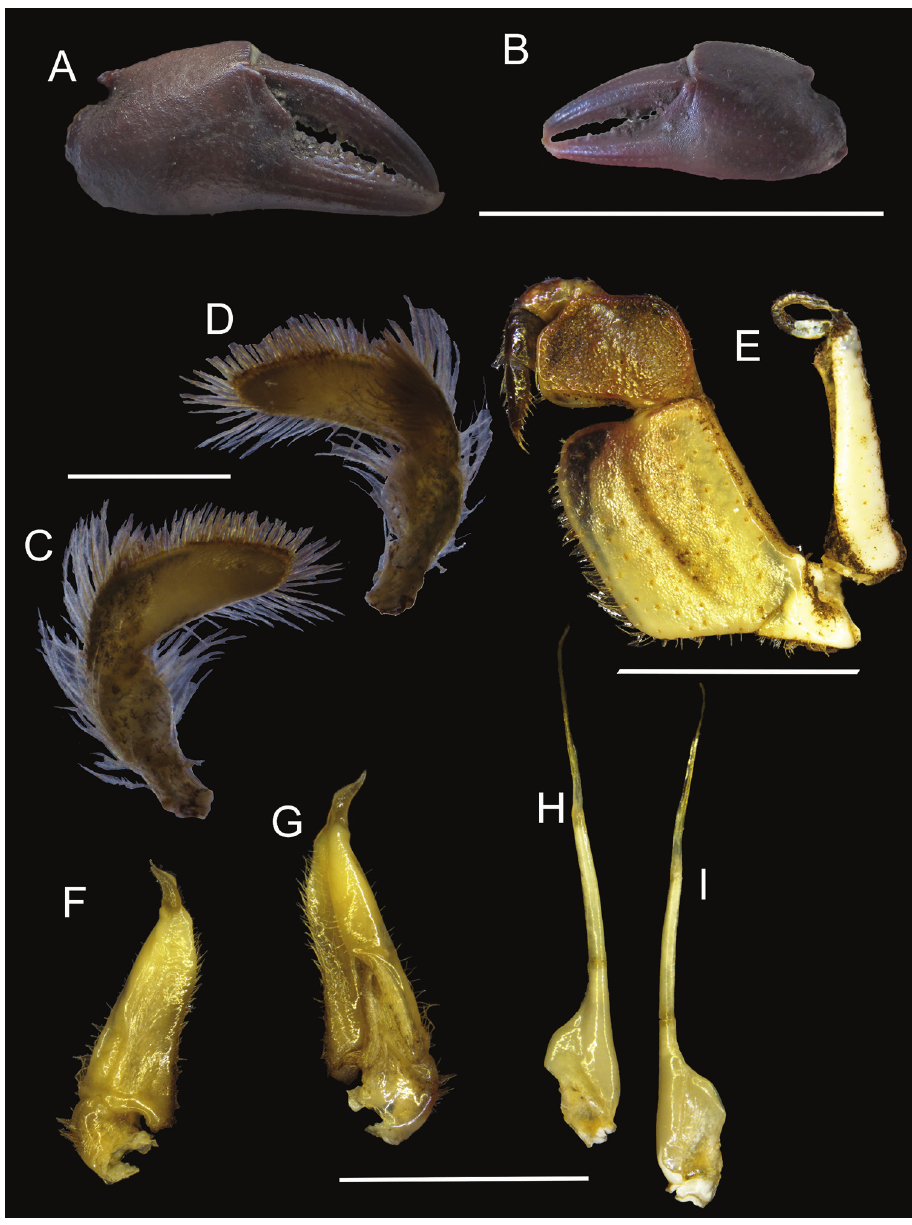
Figure 8. Potamonautes danielsi sp. n. male holotype CWW 25.8 mm (SAMC A83487). A major cheliped B minor cheliped C right mandibular palp posterior view D right mandibular palp anterior view E 3 rd maxilli- ped F left gonopod 1 anterior view G left gonopod 1 posterior view H left gonopod 2 anterior view, and I left gonopod 2 posterior view. Scale bars: 10 mm ( A, B ), 2 mm ( C, D ), 5 mm ( E ), 5 mm ( F,G, H, I ). Photos: Nasreen